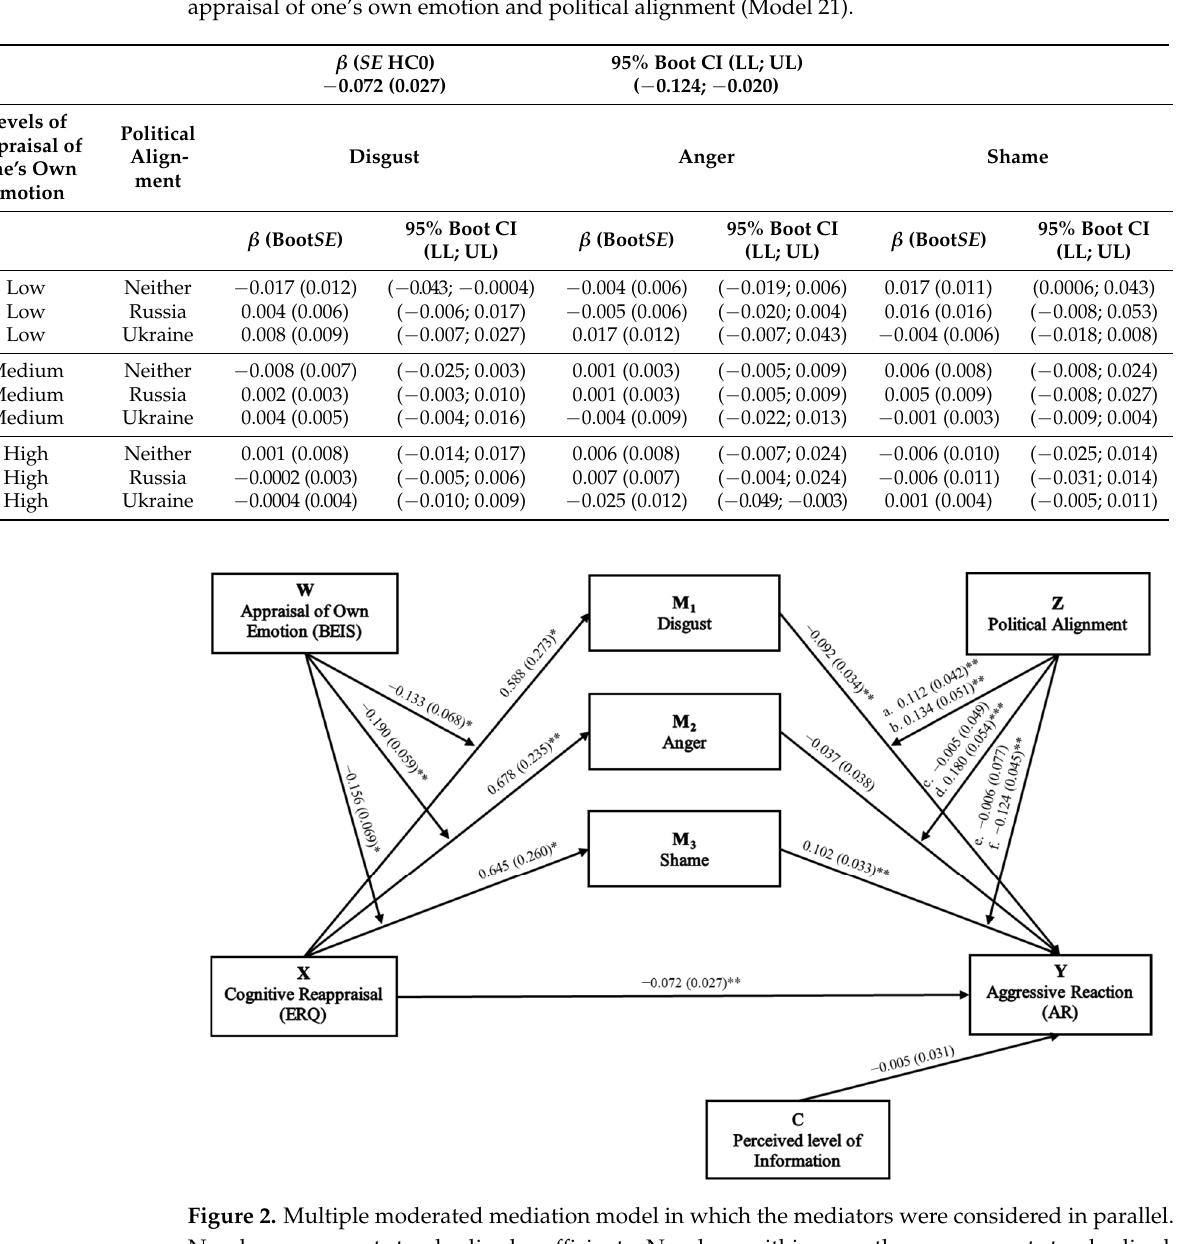
Table 5. Bootstrap direct and conditional indirect effect of reappraisal strategies on AR at values of appraisal of one’s own emotion and political alignment (Model 21).